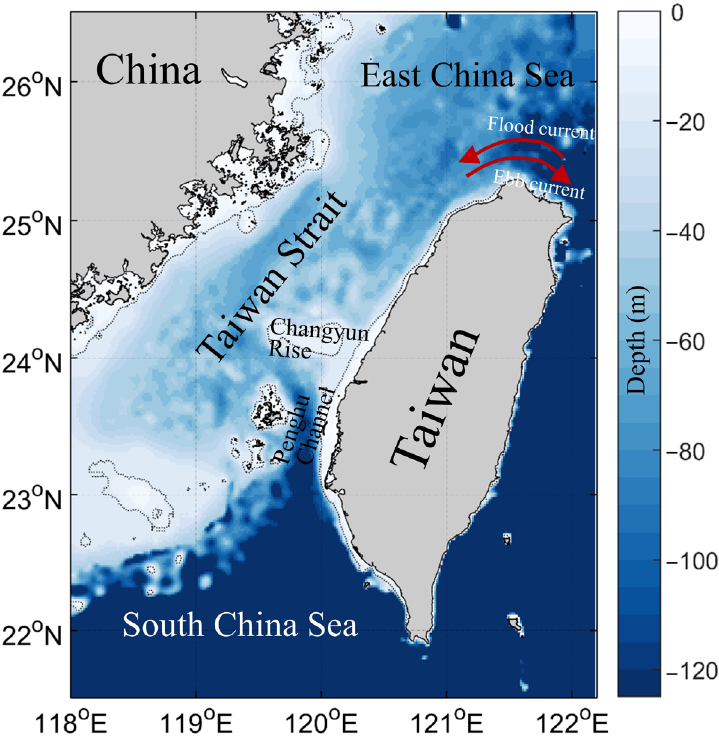
Figure 1. Topography around the TS.